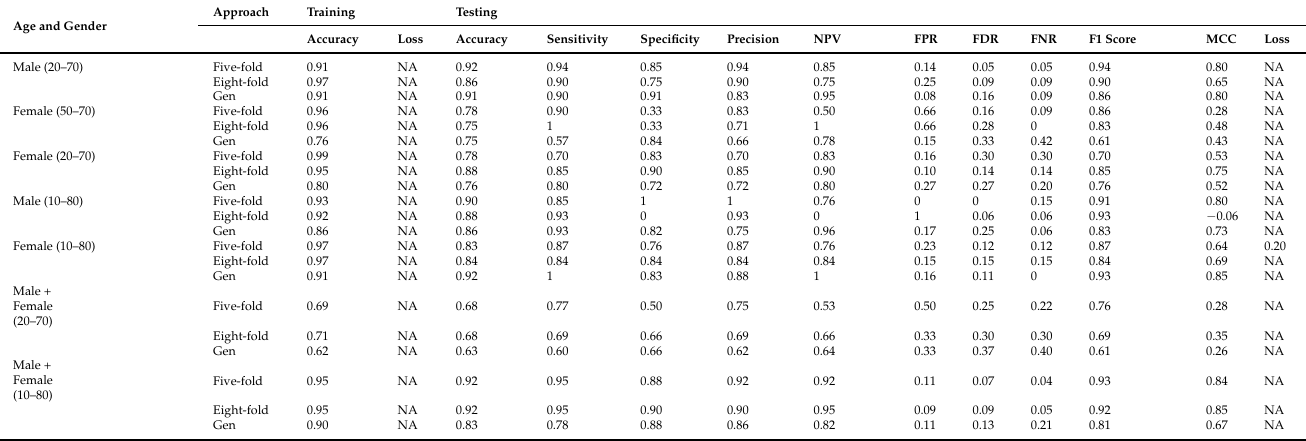
Table 8. SVM output using age and gender (Gen = Generalization